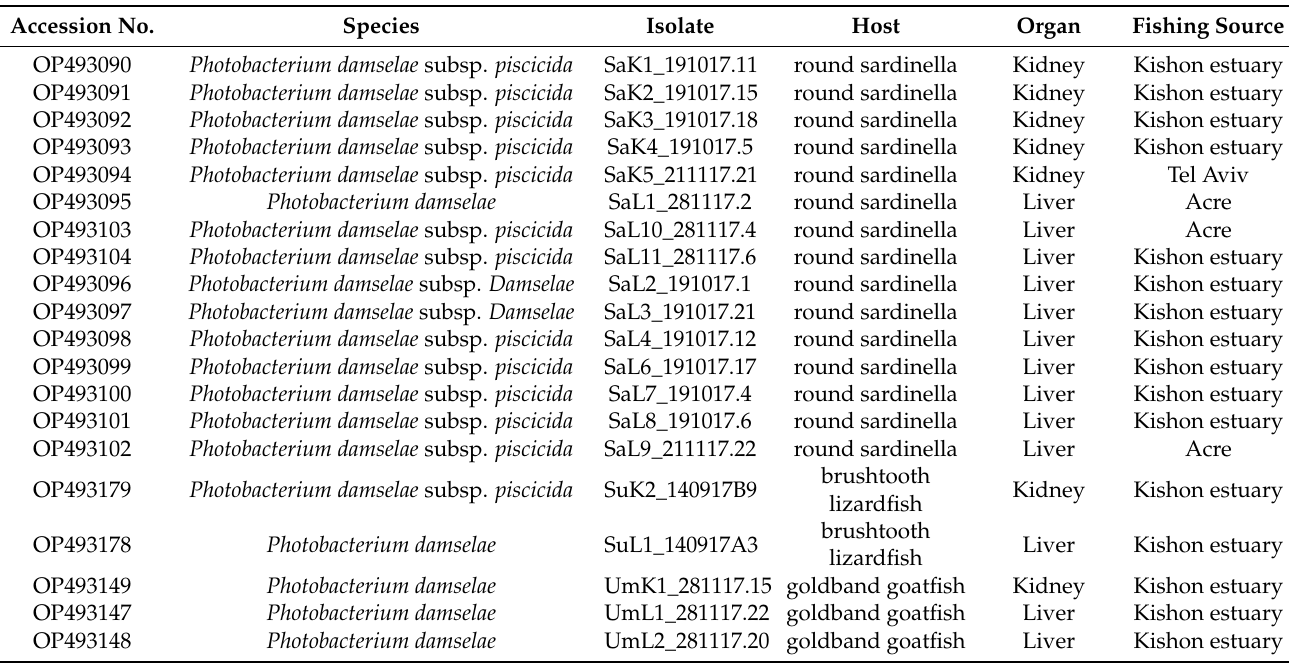
Table 3. Accession numbers and details about sequences submitted to